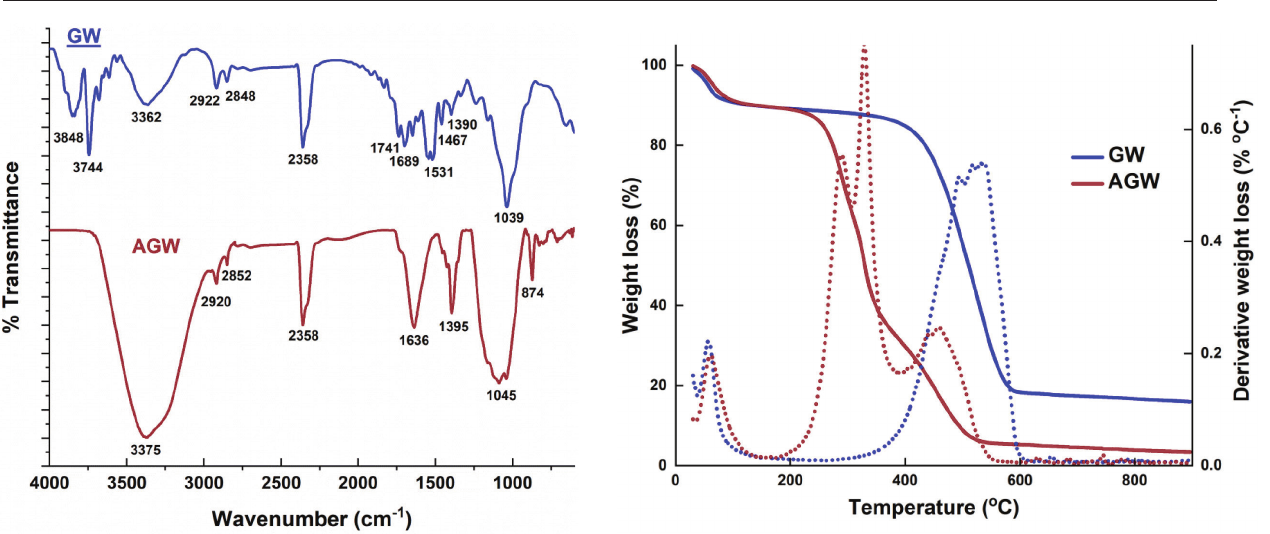
Fig. 2 – Thermogravimetric analysis of GW and